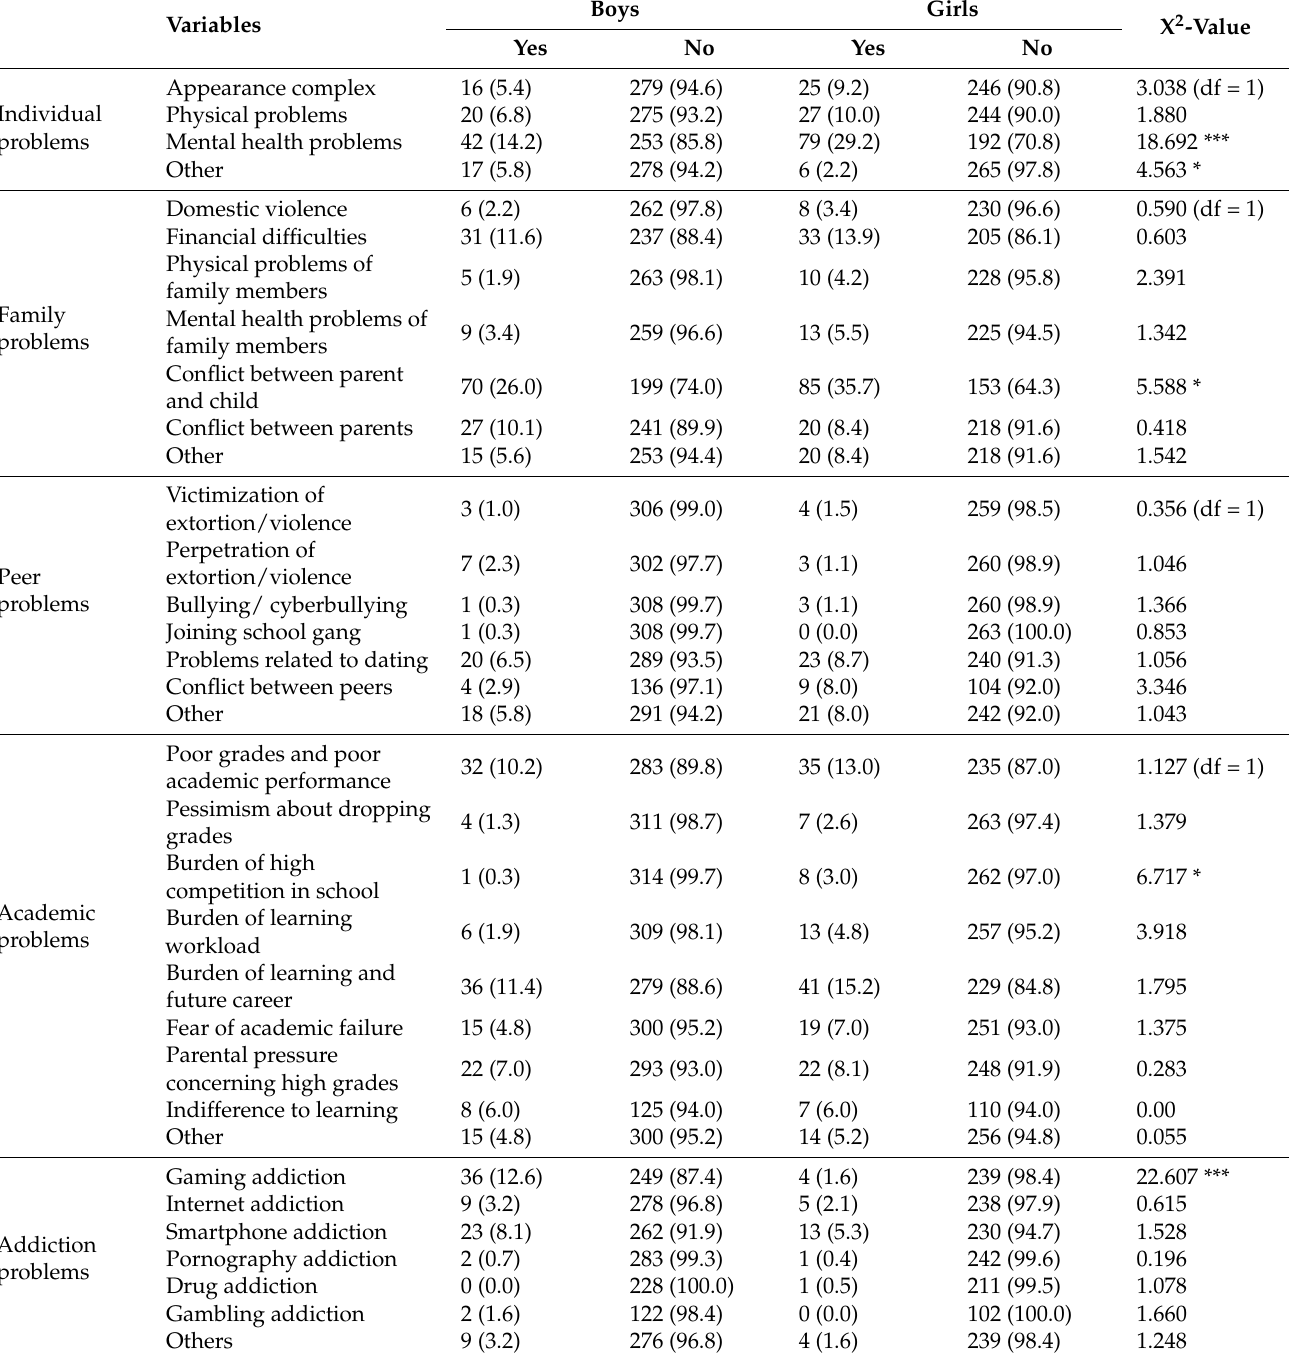
Table 4. Comparison of gender differences in concerns within 1 year of students’ deaths by suicide